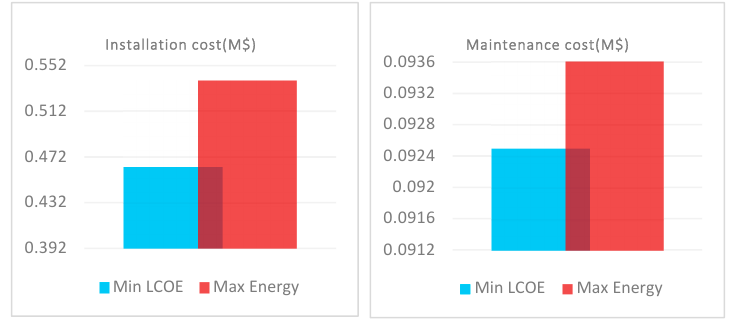
Figure 9. throughout the life of the PV plant optimised by HGWOSCA. Figure 9. Throughout the life of the PV plant optimised by HGWOSCA.